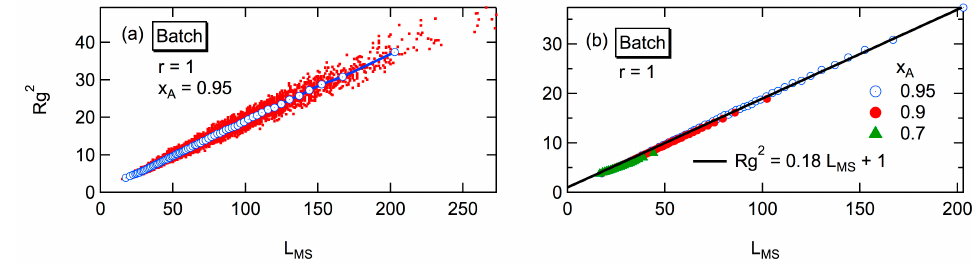
Figure 17. Universal relationship between L MS / P and the number of branch points in a polymer, DB inf P / 2 for batch polymerization.